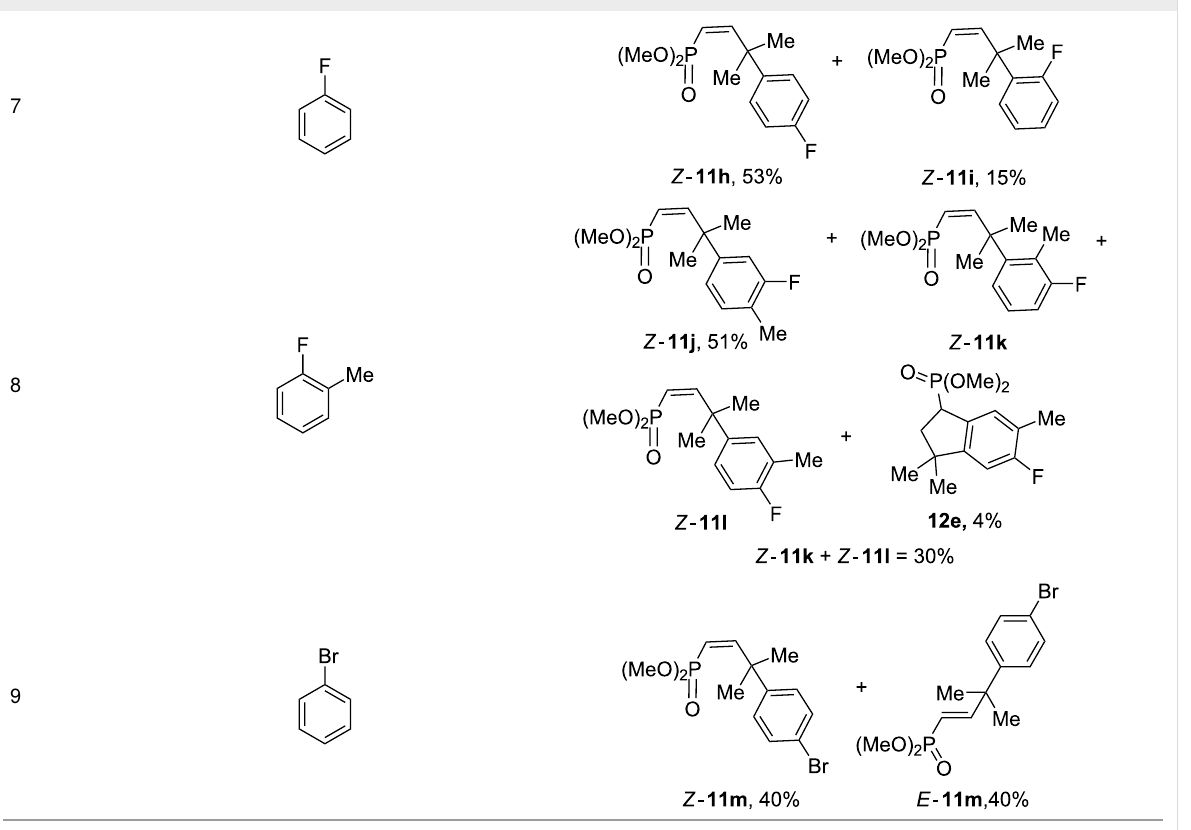
Table 3: AlCl 3 -promoted reactions of allene 1a with arenes leading to alkenes 11 and indanes 12 at room temperature for 5 min.